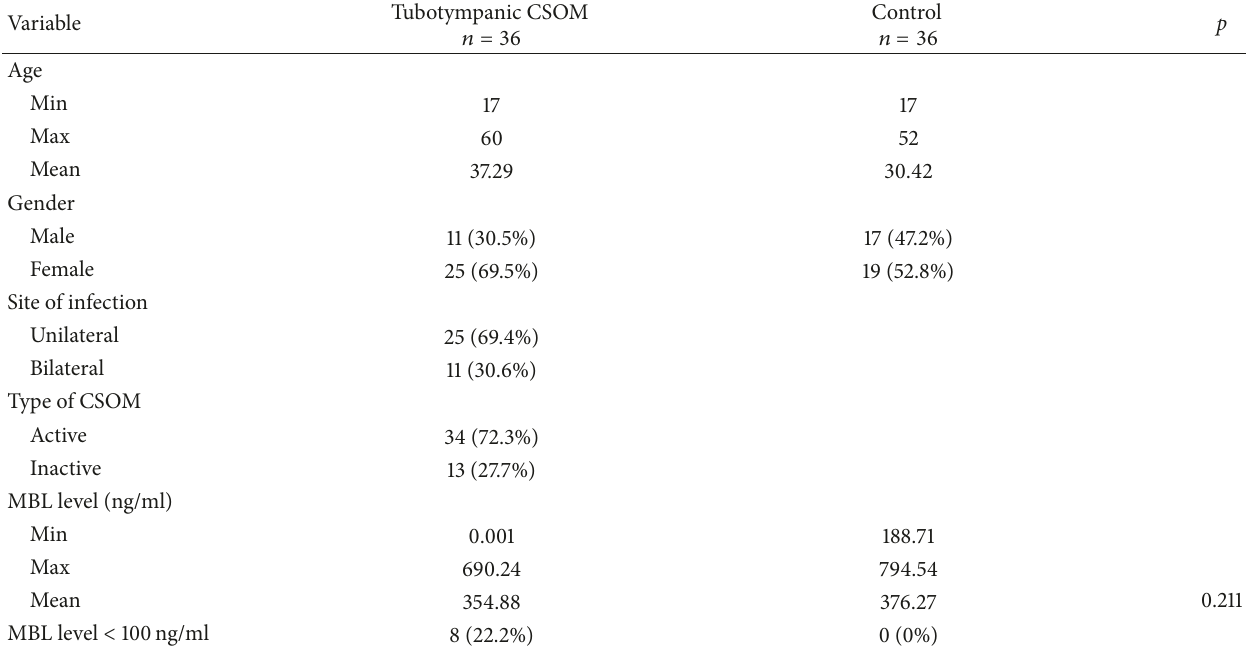
Table 1: Distribution of age, gender, and MBL level of the